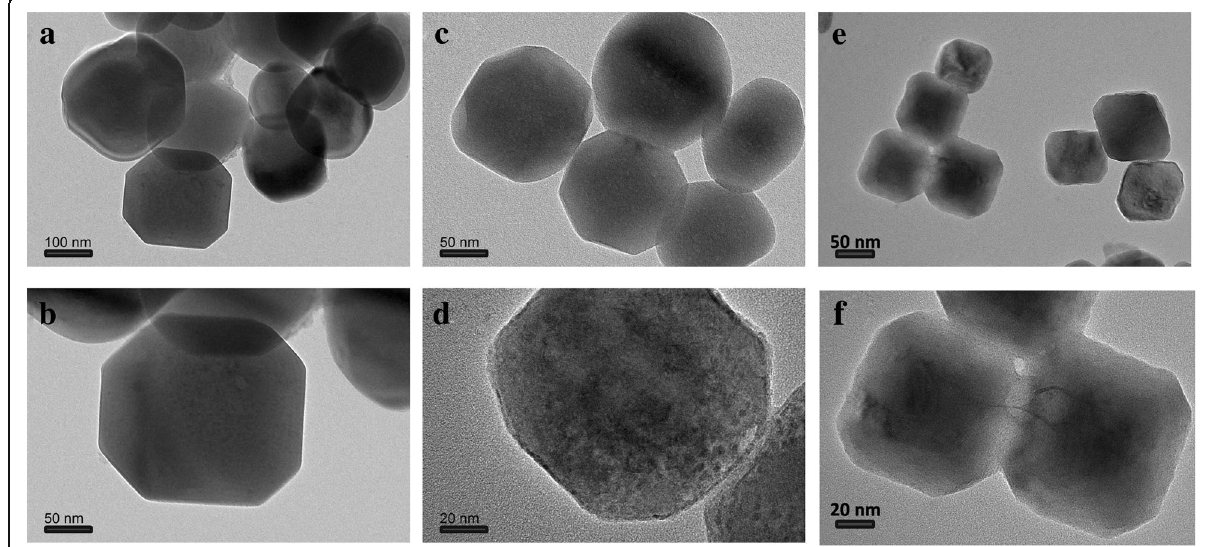
Fig. 2 TEM images of KMnF 3 ( a , b ), K(Mn 0.975 Ni 0.025 )F 3 ( c , d ), and K(Mn 0.95 Ni 0.05 )F 3 ( e , f